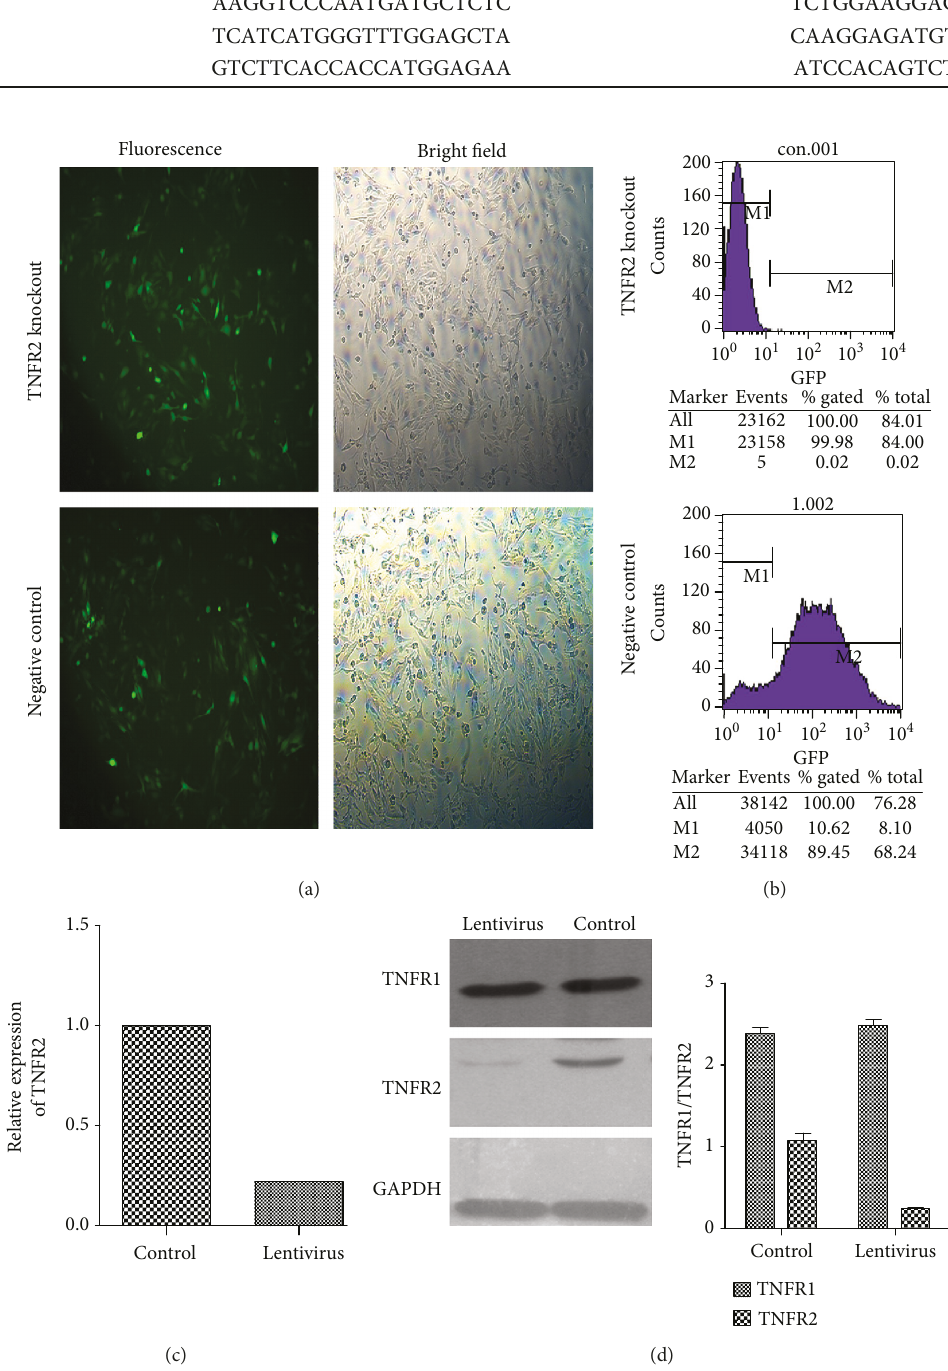
Figure 1: Silence of TNF-R2 by lentivirus transfection in the HPMECs. 20 μ L/well of lentivirus with a titre of 2 5 ∗ 109 TU/mL was added to the HPMEC suspension in a 6-well cell culture plate and cultured for 24 h. (a) The expression of the GFP lentivirus reporter gene was observed by fl uorescence microscopy, and cellular morphology was observed with bright fi eld microscopy. (b, c, d) The transfection rate was determined by fl ow cytometry, PCR, and Western blot. Flow cytometry determination of lentivirus transfection e ffi ciency was 90%. PCR showed interference with an e ffi ciency of 78%, and Western blot results showed interference with an e ffi ciency of